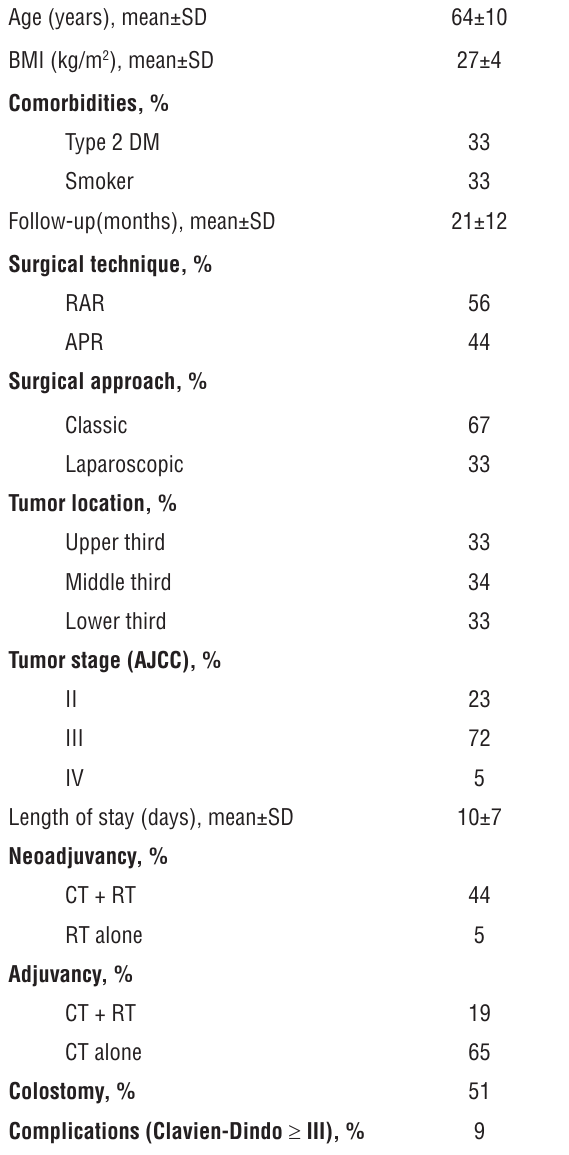
Table 1 – Baseline characteristics of patients included in the